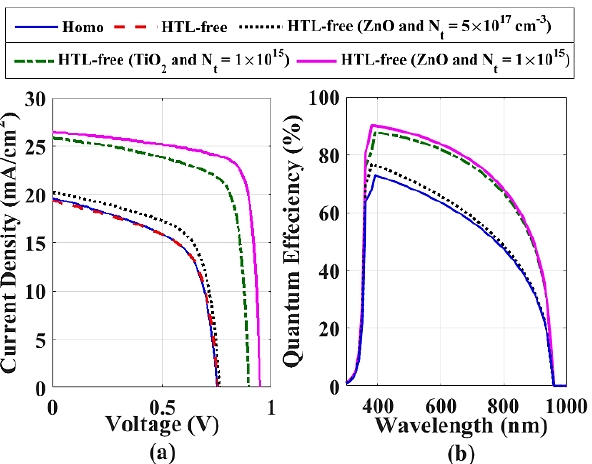
Figure 19. A comparison between ( a ) the illuminated J – V characteristics and ( b ) quantum efficiency of optimized HTL-free and other cases of homo-junction-based lead-free PSCs.